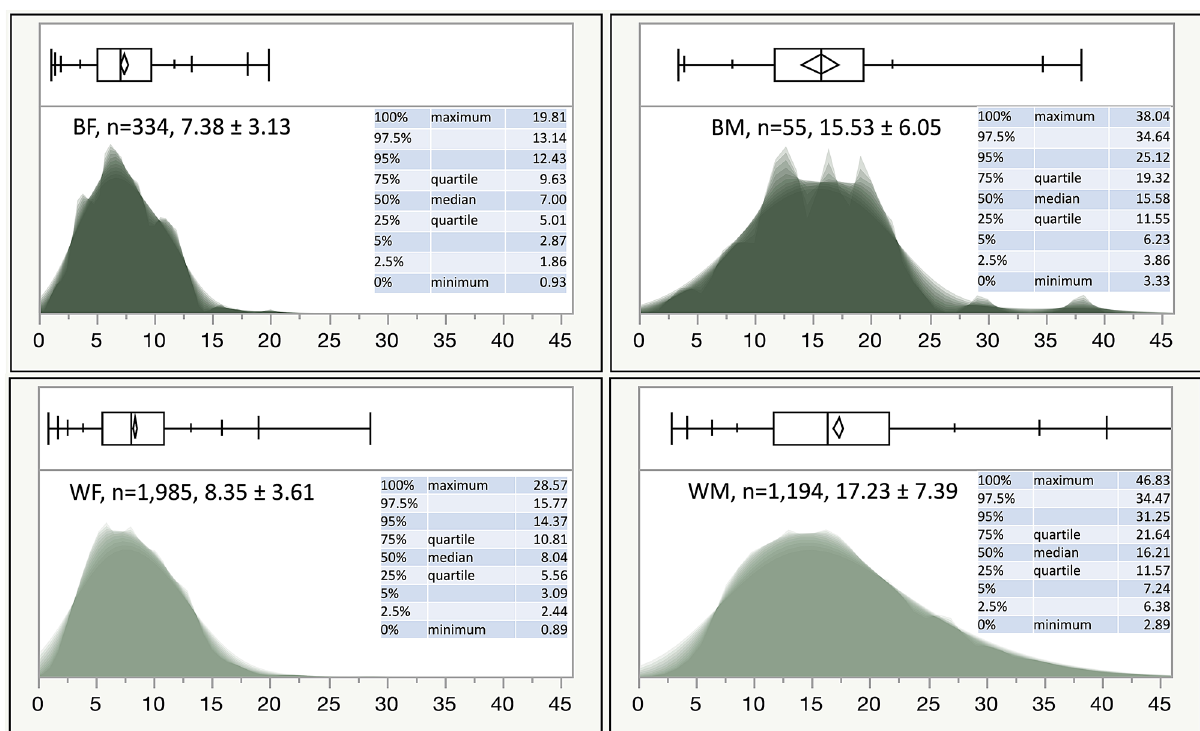
Figure 1. Shadowgrams (overlayed histograms with various X axis bin widths) of AEX by gender and race/ ethnicity. To understand the concept of a shadowgram, consider that if the bin width (on the X axis) of a histogram is different, its appearance changes. As such, a shadowgram overlays histograms with different bin widths. Dominant features of the distribution are less transparent on a shadowgram. B black, W white, F females, M males. Color codes—dark green: blacks; light green: whites.